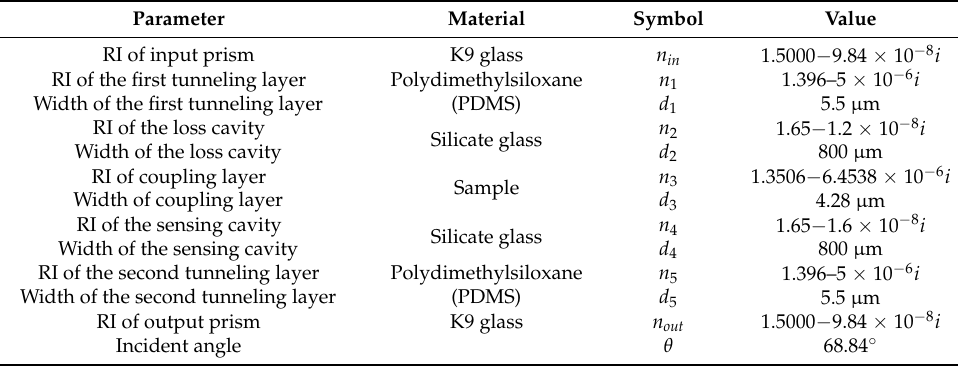
Figure 1. Schematic graph of the biosensor structure based on the resonant optical tunneling effect (ROTE) structure. Table 1. Parameters and materials of the coupled ROTE resonators.